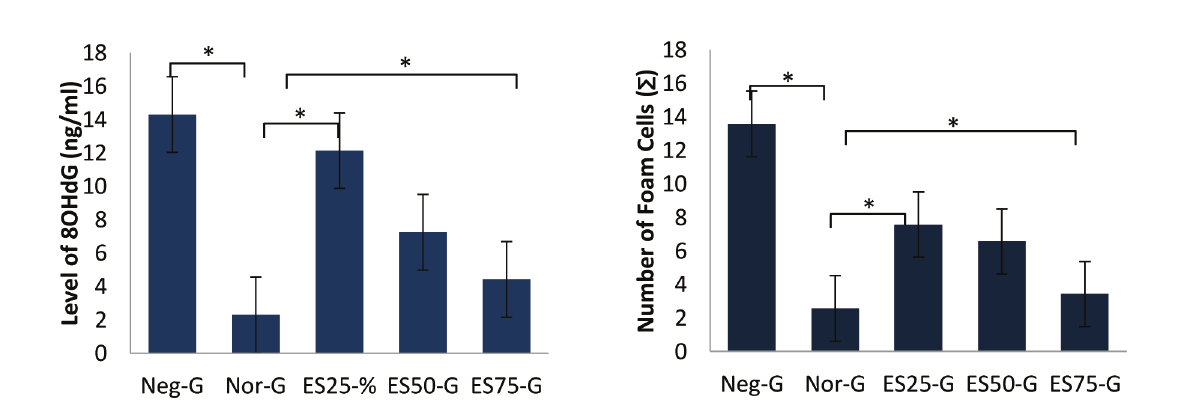
Figure 2. Mean of 8-OHdG and Number of Foam Cells for Each Group. Mann Withney Test: * p